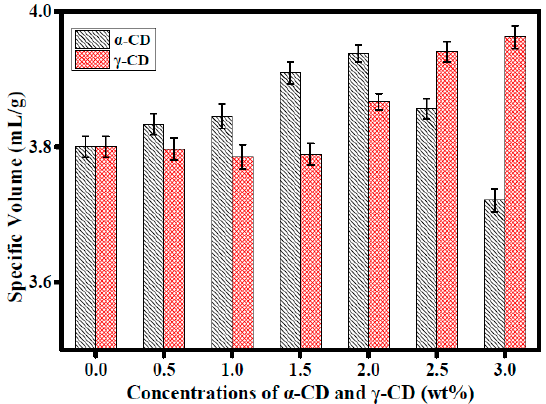
Figure 4. Effects of the addition of 0–3.0 wt% α -CD and γ -CD on the specific volume of frozen prebaked bread (frozen for three days). Samples were tested three times. The average of three measurements was calculated. Each group was tested six times in